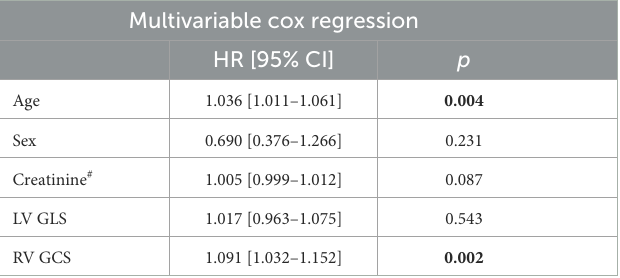
TABLE 3 Independent predictors of all-cause mortality identified using multivariable cox regression. Multivariable cox regression